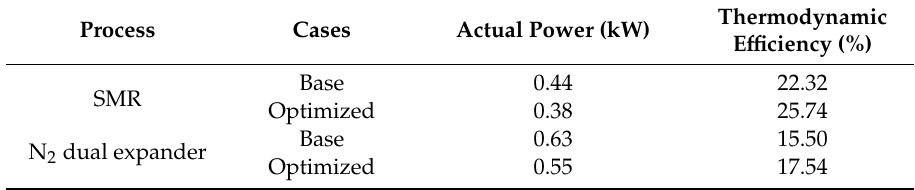
Table 13. Actual work and thermodynamic e ffi ciency of LNG and N 2 dual expander